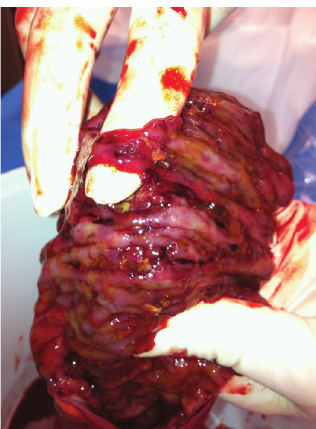
Figure 1: Extensive ulceration affecting the descending and sigmoid colon.